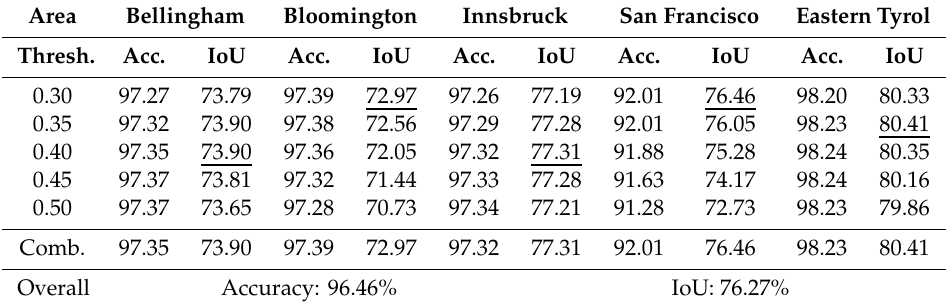
Table 5. The o ffi cial competition results.